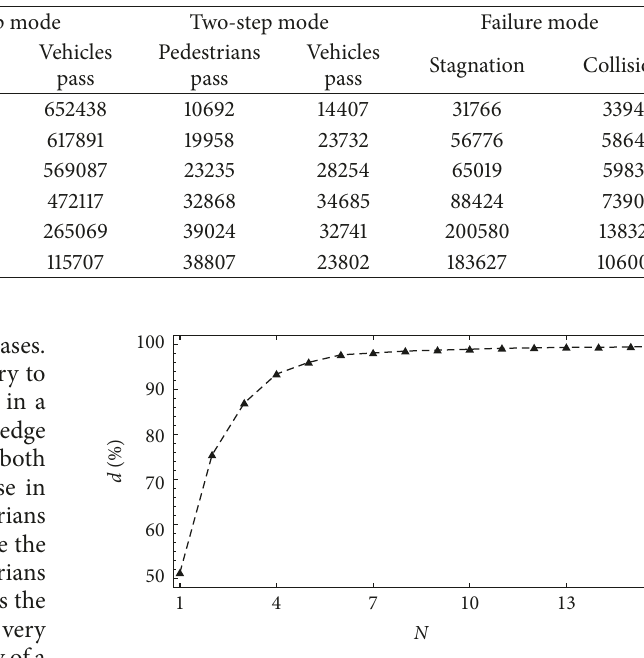
Figure 3: The crossing probability for pedestrians for different group sizes ( 𝑑 is the ratio of the sample number of pedestrians crossing to the total sample size; the theoretical time of vehicles is 𝑢 = 𝐿/ V = 4 s; the total sample size is 1,000,000). 𝑐